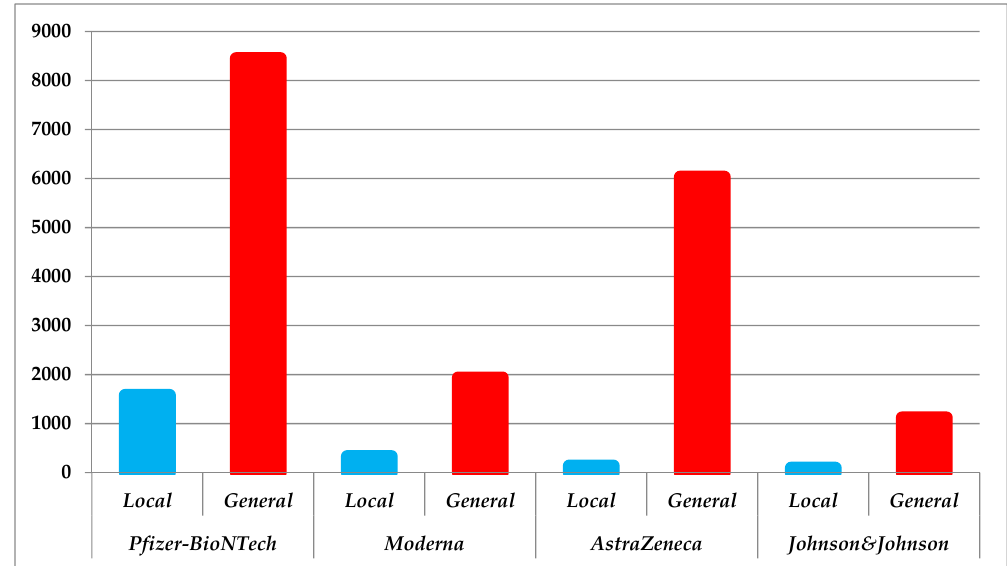
Figure 3. Graphic highlighting the total number of adverse reactions (local vs. general) reported in Romanian individuals.